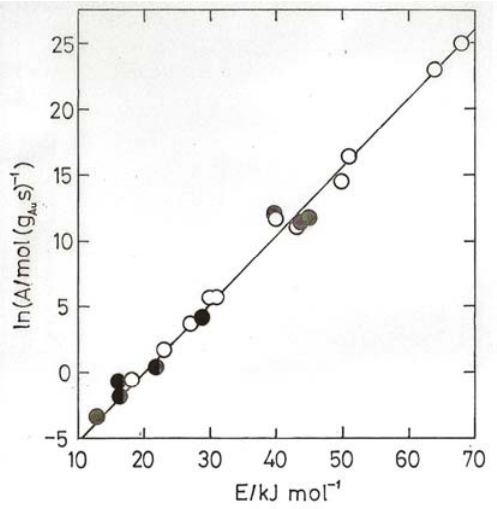
Figure 7. Compensation plot for CO oxidation over Au supported on mixed oxide supports (open circles, Fe + Sn, Ce, Zr, Ti [50]; Ce + La, Fe, Zr [51]) and single oxides (filled circles, Fe, Co, Ce, Zr, Si)